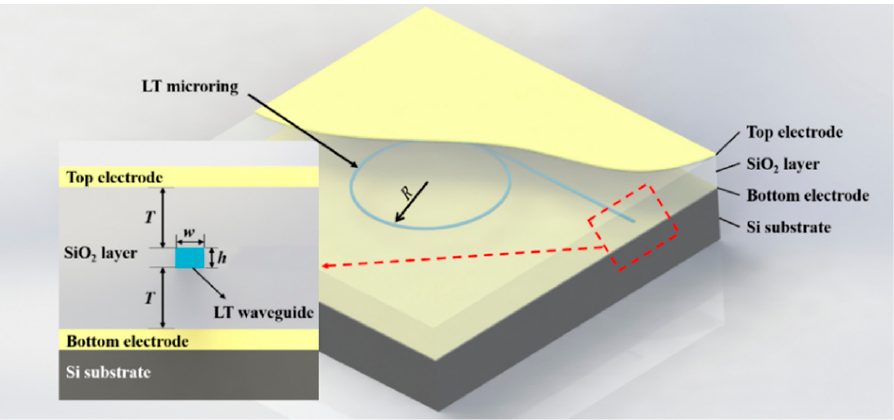
Figure 1. Schematic showing the waveguide-coupled microring resonator on LTOI. Inset: cross- section of the LT waveguide structure.